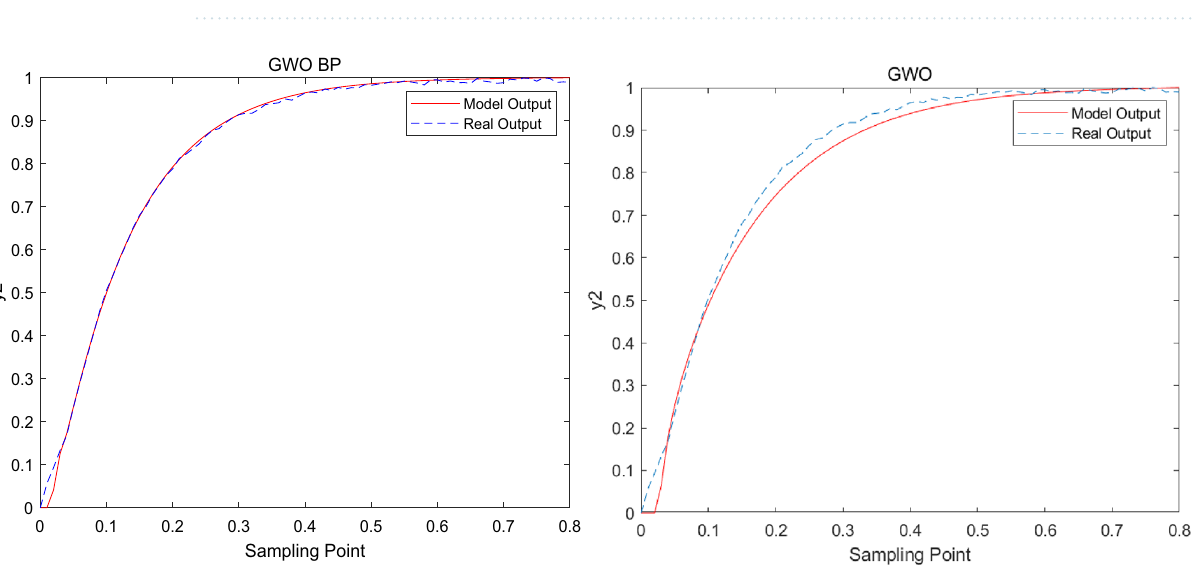
Figure 2. Modeling result graph of y 1 .